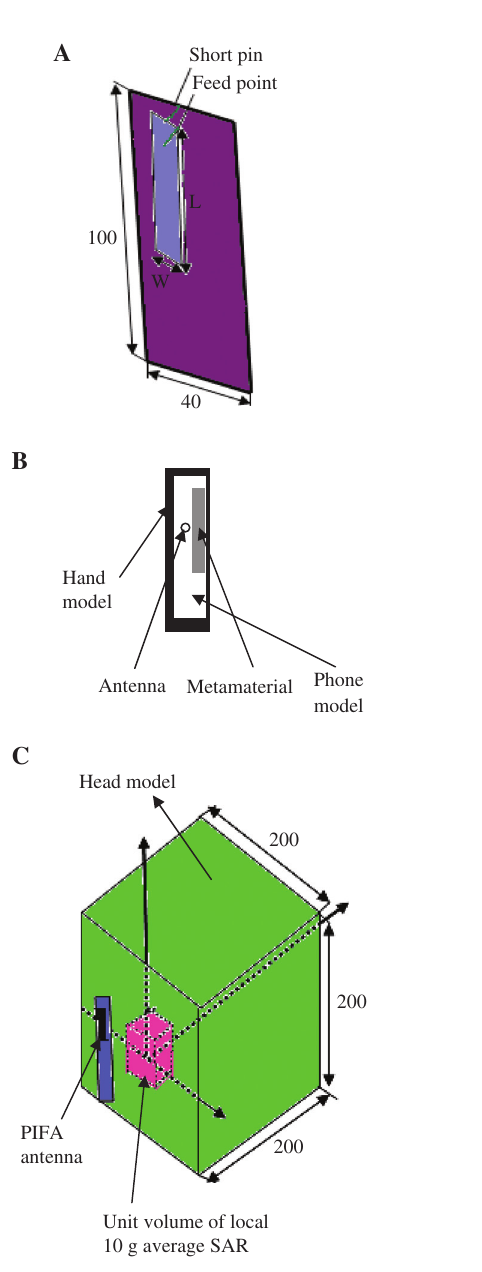
Figure 1 Head-phone model for SAR calculation: (A) antenna with phone model, (B) metamaterial attachment with hand phone model, (C) cubical head model.